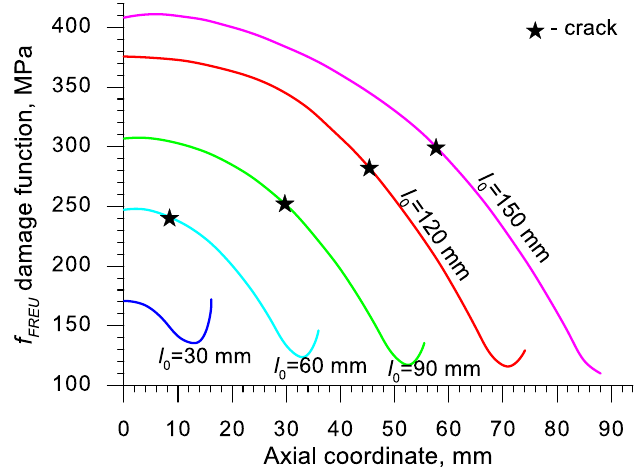
Figure 17. Exemplary roentgenograms of the rotationally compressed samples; dimensions of the samples—diameter 30 mm, initial length (from the left) 30, 60, 90, 120 and 150 mm.